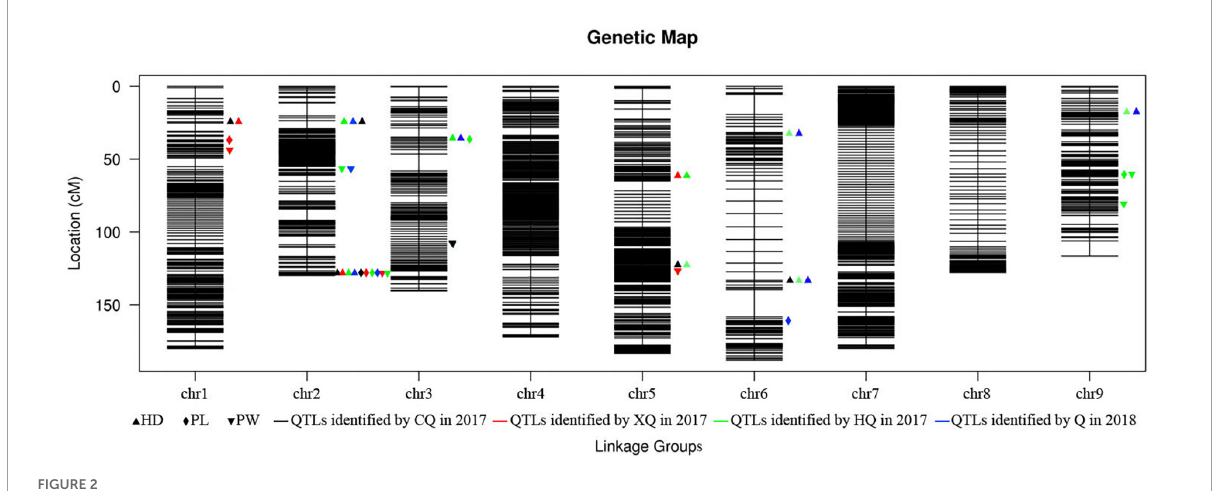
FIGURE2 High-density genetic map and summary of the identified